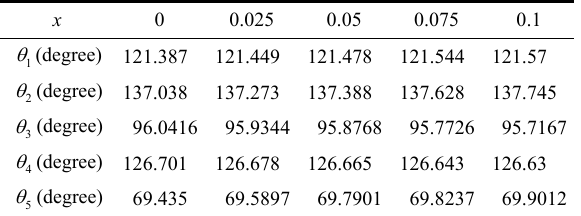
Table 5 Variation of bond angle for Mn 0.5 Zn 0.5 Gd x Fe 2– x O 4 ( x = 0, 0.025, 0.050, 0.075, and 0.1) nanoparticle